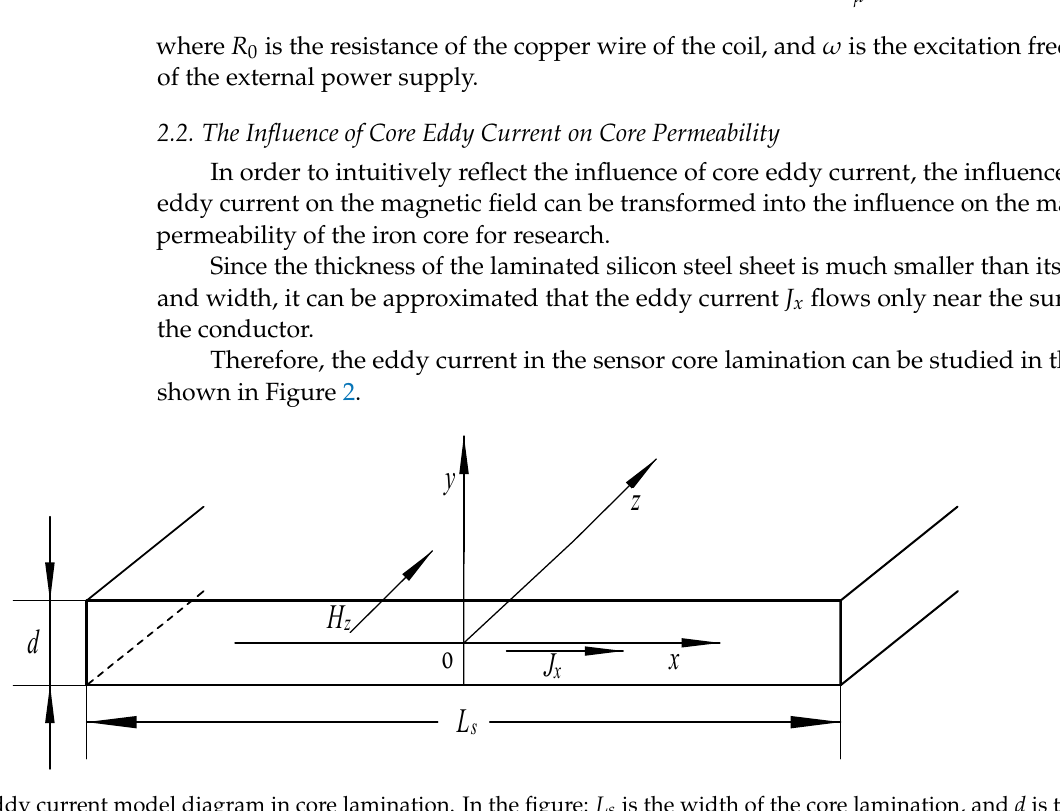
Figure 2. Eddy current model diagram in core lamination. In the figure: L s is the width of the core lamination, and d is the thickness of the core lamination.